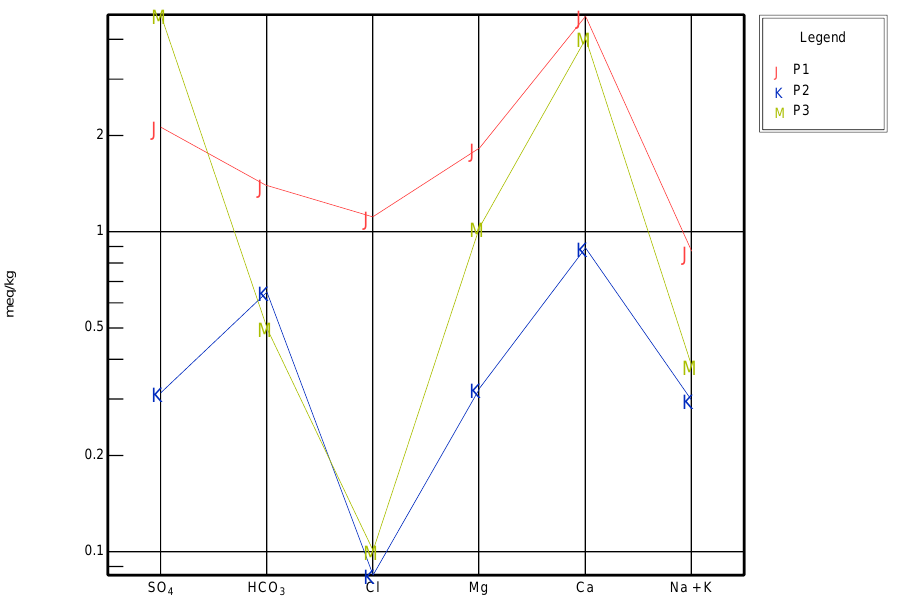
Figure 4. Schoeller diagram of chemical parameters concentrations (SO 4 2− , HCO 3 − , Cl − , Mg, Ca, K, Na) among the sampling points.